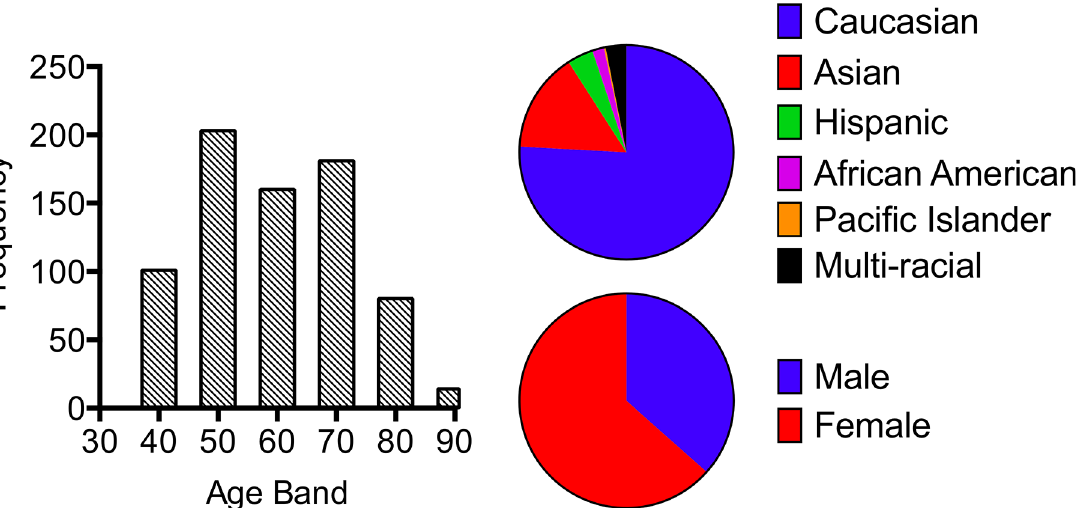
Fig 1. Demographics of the cohort of 740 participants, including age band, race/ethnicity, and sex. Results are representative of the aging population in the San Francisco Bay Area. A subset of 240 of these individuals was selected for further immunological analysis; this subset included all individuals age 78 and above, with an equal number of 40 – 50 year olds, and lower representation of the middle age